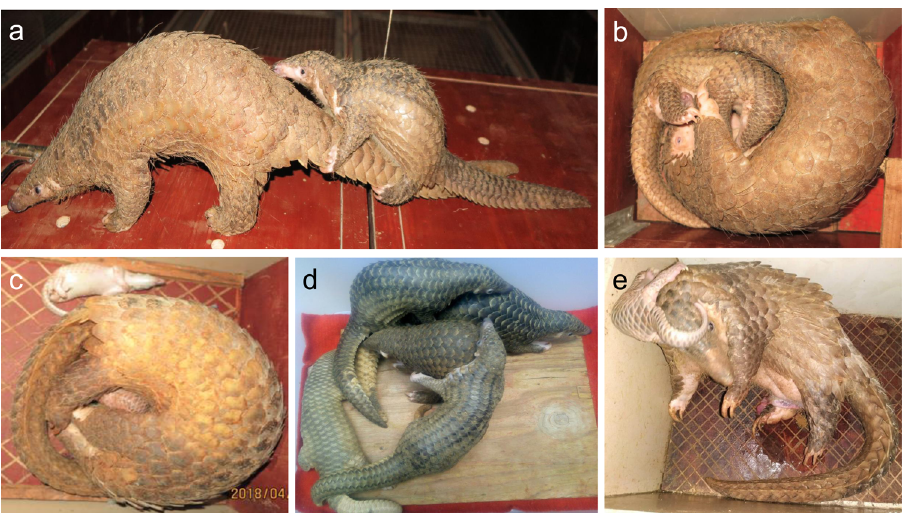
Fig. 1 Captive-born pangolins. a Female pangolin WF11 carrying her offspring FG3 on her tail. For more details on how a pangolin carries her offspring, please watch Supplementary Video 1. b Female pangolin WF16 nursing her offspring FG5. c Female pangolin WF8 was giving birth to a twin FG15.1 and FG15.2. FG15.2 died during birth. d A group of the fi rst fi lial generation pangolins (FG1, FG2, FG3, FG4 and FG5) playing together. e Second fi lial generation female pangolin SG4 after recently having given birth to a third fi lial generation offspring TG2. The placenta can still be seen attached to the body of SG4. (Photos: Dingyu Yan).